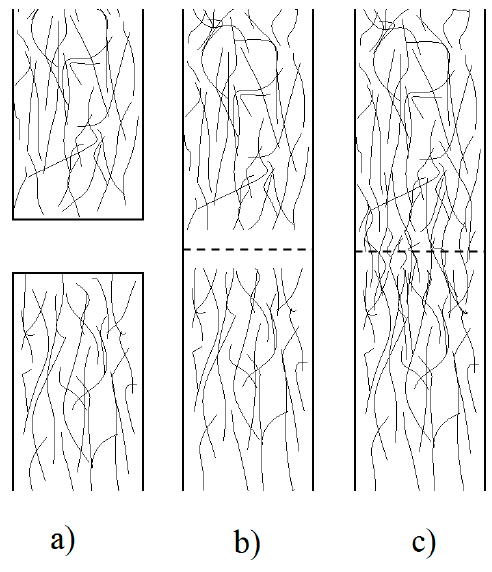
Figure 13. Intimate contact and autohesion stages of the consolidation phenomena: ( a ) Two distinct interfaces; ( b ) achievement of intimate contact; ( c ) collapse of the interface (autohesion).